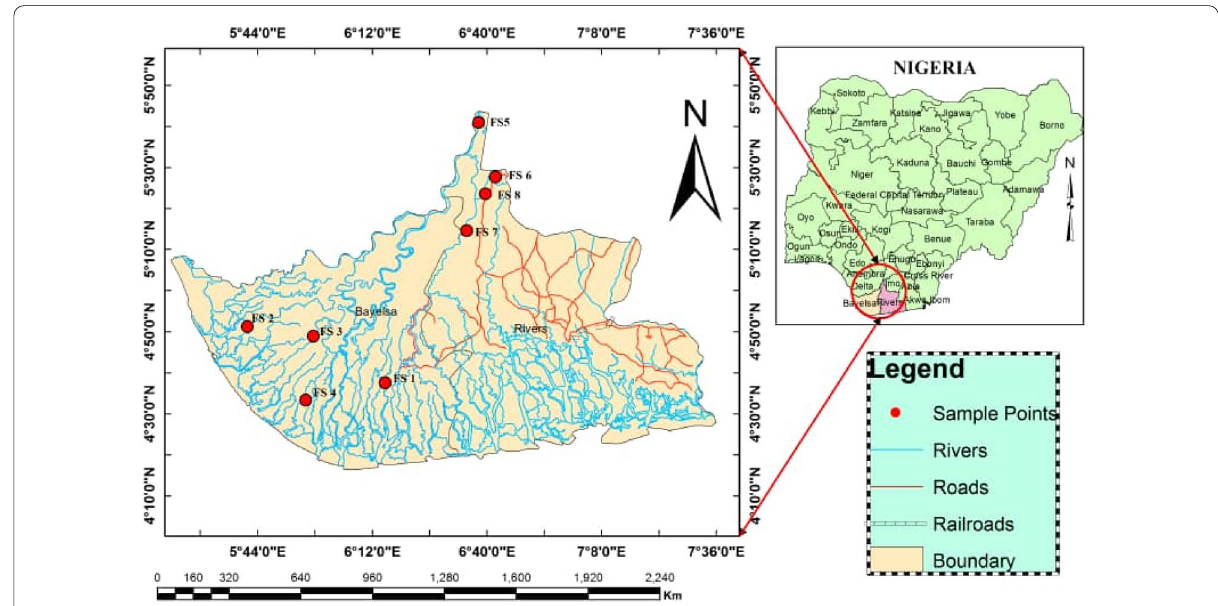
Fig. 1 Map of Nigeria showing the sampling